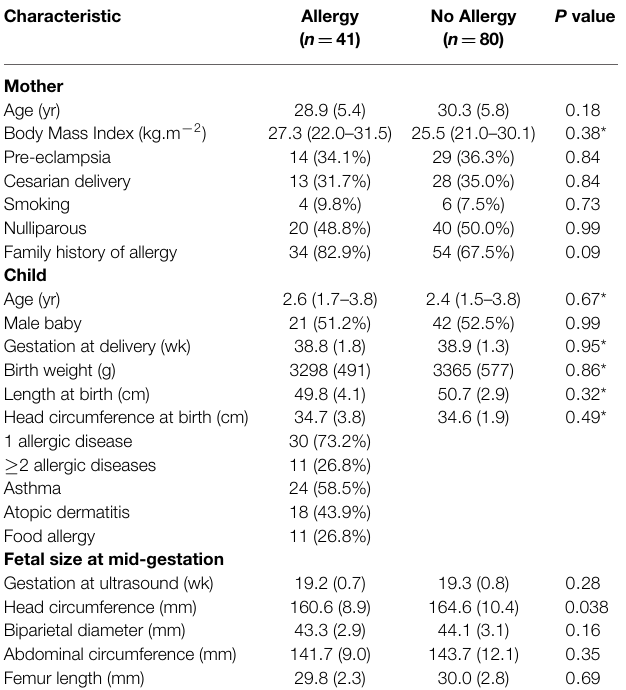
TABLE 1 | Participant characteristics .